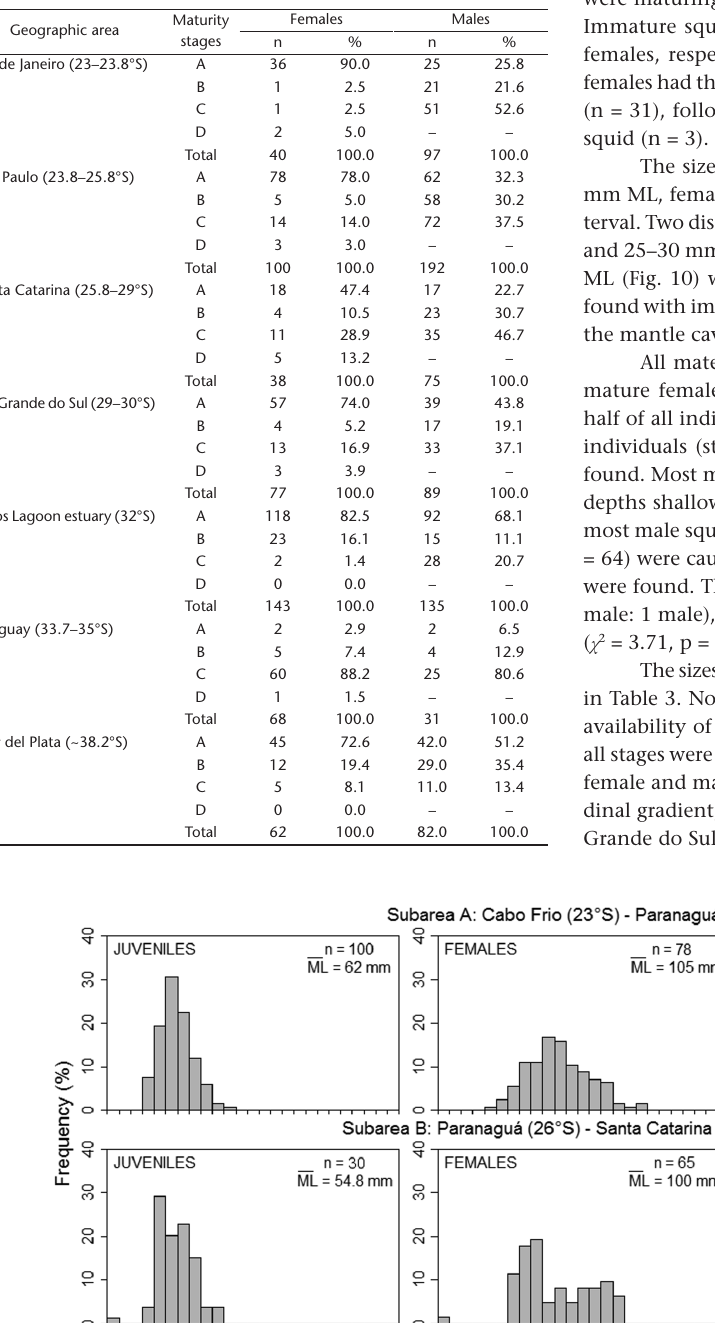
Table 2. Number of females and males of Doryteuthis sanpaulensis of each maturity stage per geographical area.